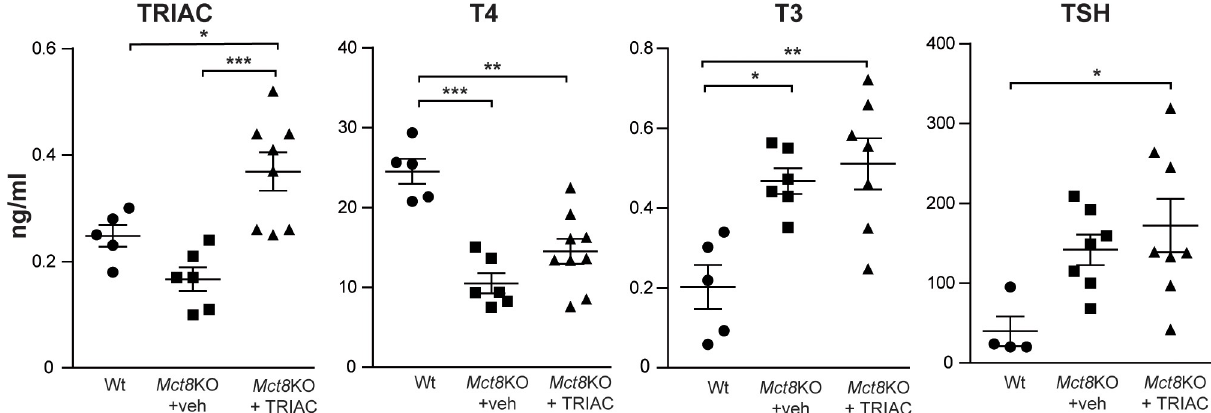
Fig 1. Triiodothyroacetic acid (TRIAC), thyroxine (T4) and 3,5,3’-triiodothyronine (T3) levels in plasma of vehicle treated wild type (Wt; TRIAC n = 5; T4 n = 5; T3 n = 5 and TSH n = 4) and monocarboxylate transporter 8 knock out ( Mct8 KO+veh; TRIAC n = 6; T4 n = 6; T3 n = 7 and TSH n = 7) and in Mct8 KO mice after intracerebroventricular (ICV) administration of therapeutics doses of 30 ng/g of body weight (BW) of TRIAC per day for 12 days ( Mct8 KO+TRIAC; TRIAC n = 8; T4 n = 9; T3 n = 7 and TSH n = 8). Measures were obtained by specific radioimmunoassays. Data are expressed as scatter plots and mean ± SEM and � p < 0.05, �� p < 0.01 and ��� p < 0.001 were determined by one-way analysis of variance (ANOVA) and Bonferroni’s post hoc test except for TSH levels that were determined by the Kruskal-Wallis test.